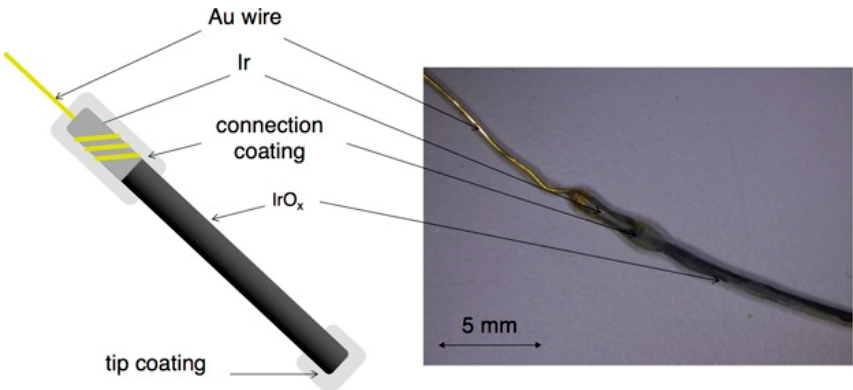
Figure 3. Schematic illustration and stereomicroscopy image of pH sensor based on an IrO x electrode [50].